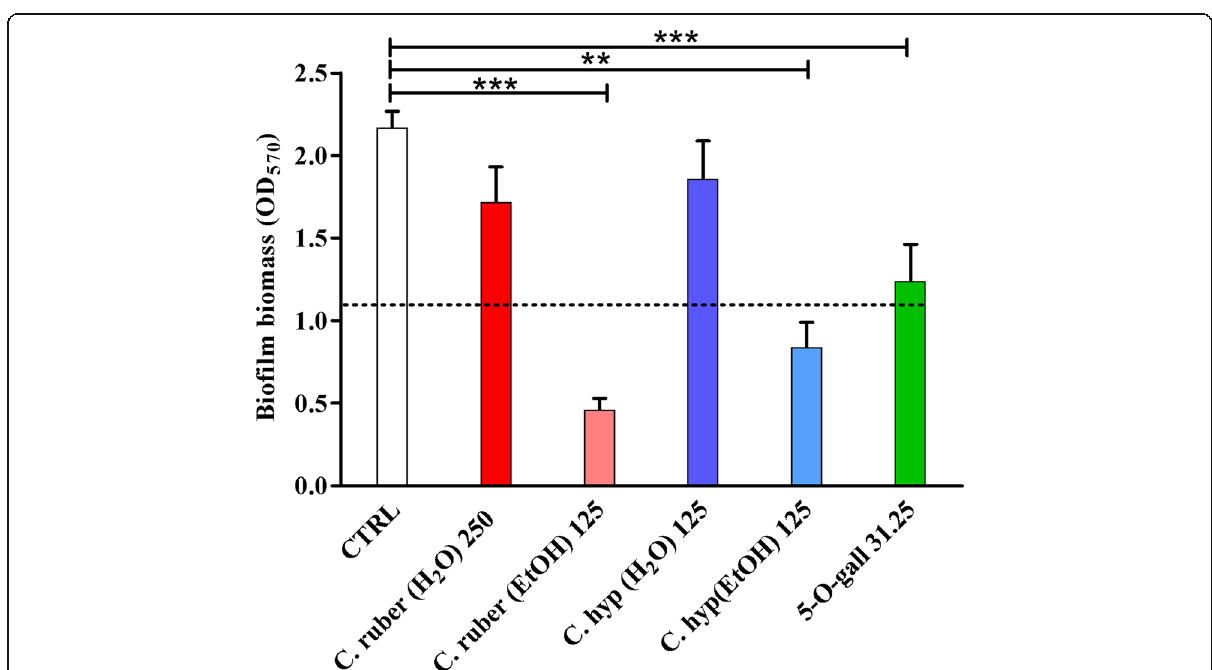
Fig. 4 Inhibitory effect of Cytinus hypocystis and Cytinus ruber extracts (at concentrations ranging from 125 to 250 μ g/ml) and penta-O-galloyl- β - D-glucose (abbreviated as 5-O-gall in the graph; 31.25 μ g/ml) on biofilm formation of S. epidermidis ATCC 35984. The inhibitory effect was assessed by measuring the total biofilm biomass by crystal violet staining after 24 h of incubation with the extracts. Control (CTRL) represents untreated bacteria. Concentrations are expressed in μ g/mL. Dashed lines represent 50% reduction in biofilm biomass as compared to untreated controls. Data are reported as mean ± standard error of at least three independent experiments. ∗∗ p < 0.01; ∗∗∗ p < 0.001 (one-way ANOVA followed by Tukey-Kramer post hoc